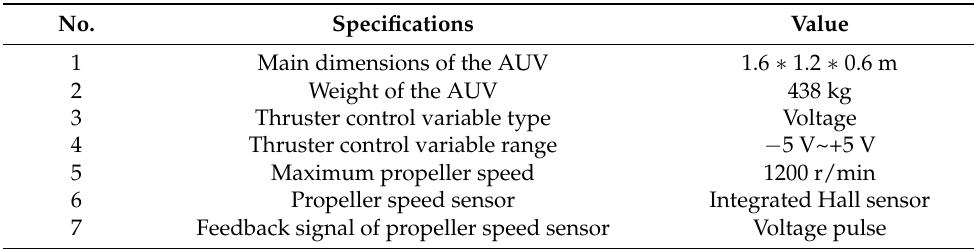
Figure 11. The saucer-shape AUV in pool test. Table 2. Specifications of the saucer-shape